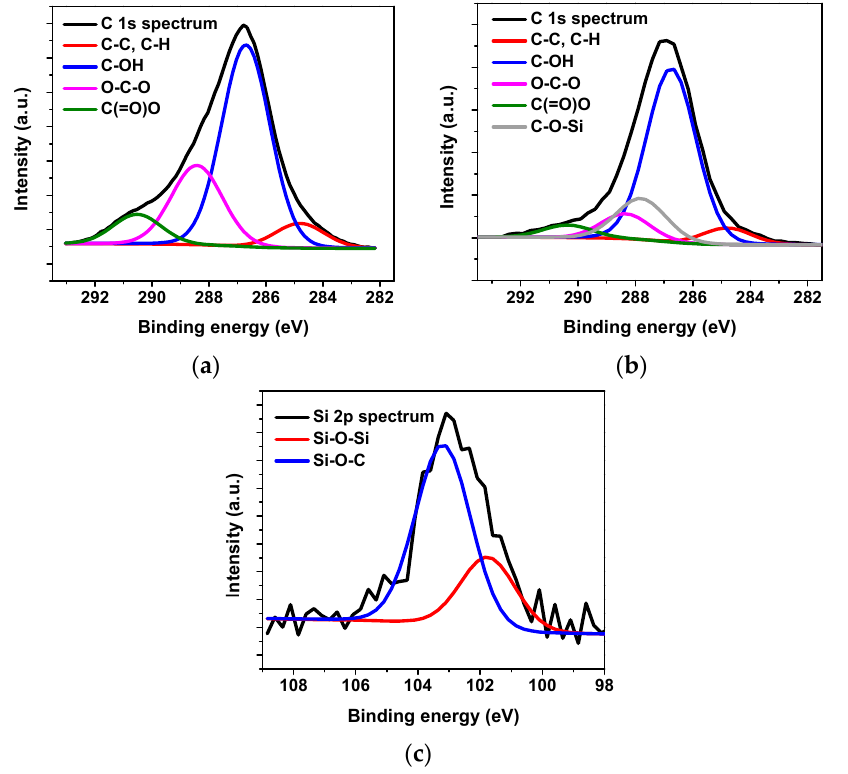
Figure 4. Fitted high resolution C 1s XPS spectra of CNFs ( a ) and TMPES-modified CNFs films ( b ). Fitted high resolution Si 2p XPS spectra of TMPES-modified CNFs films ( c ).